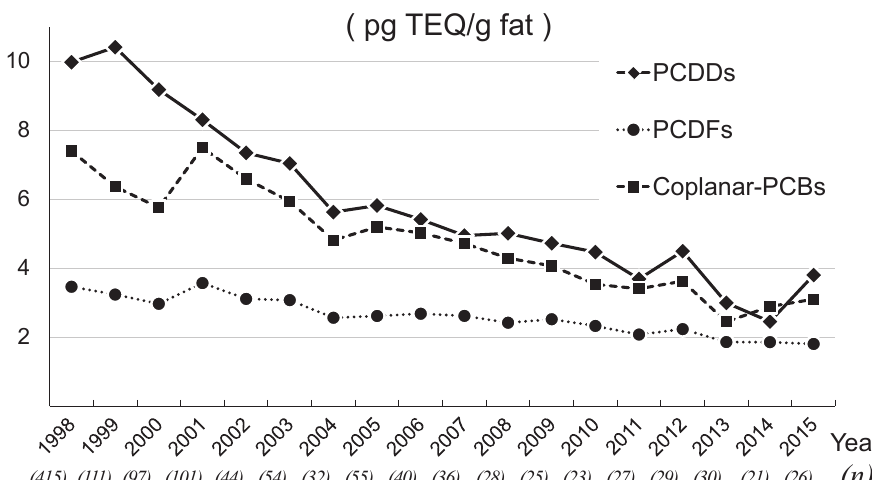
Figure 3. Annual trends in levels of PCDDS, PCDFs, and coplanar PCBs, 1998 – 2015. Annual levels of PCDDs (7 isomers), PCDFs (10 isomers), and coplanar PCBs (12 isomers) are shown with the means during the study period (1998 – 2015). Each value given in parentheses under the calendar year represents the sample size in each year. The 95% con fi dence interval bars were omitted for fi gure clarity. PCDD, polychlorinated dibenzo- p -dioxin; PCDF, polychlorinated dibenzofuran; PCB, polychlorinated biphenyl.